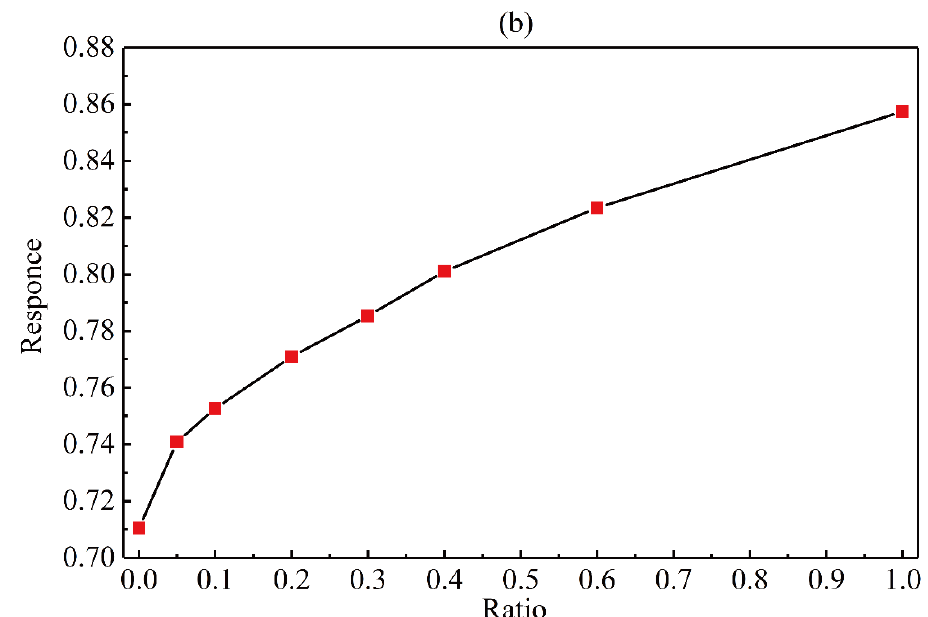
Figure 5. SPR response of helium and argon in different ratios: ( a ) 0% means full of helium, 100% means full of argon. ( b ) Response curve as the ratio varies.